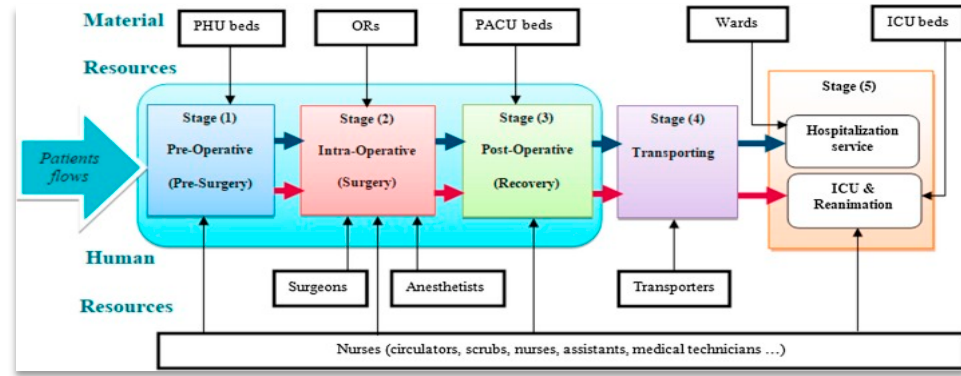
Figure 2. The three stages of the surgical process and its involved resources [78].